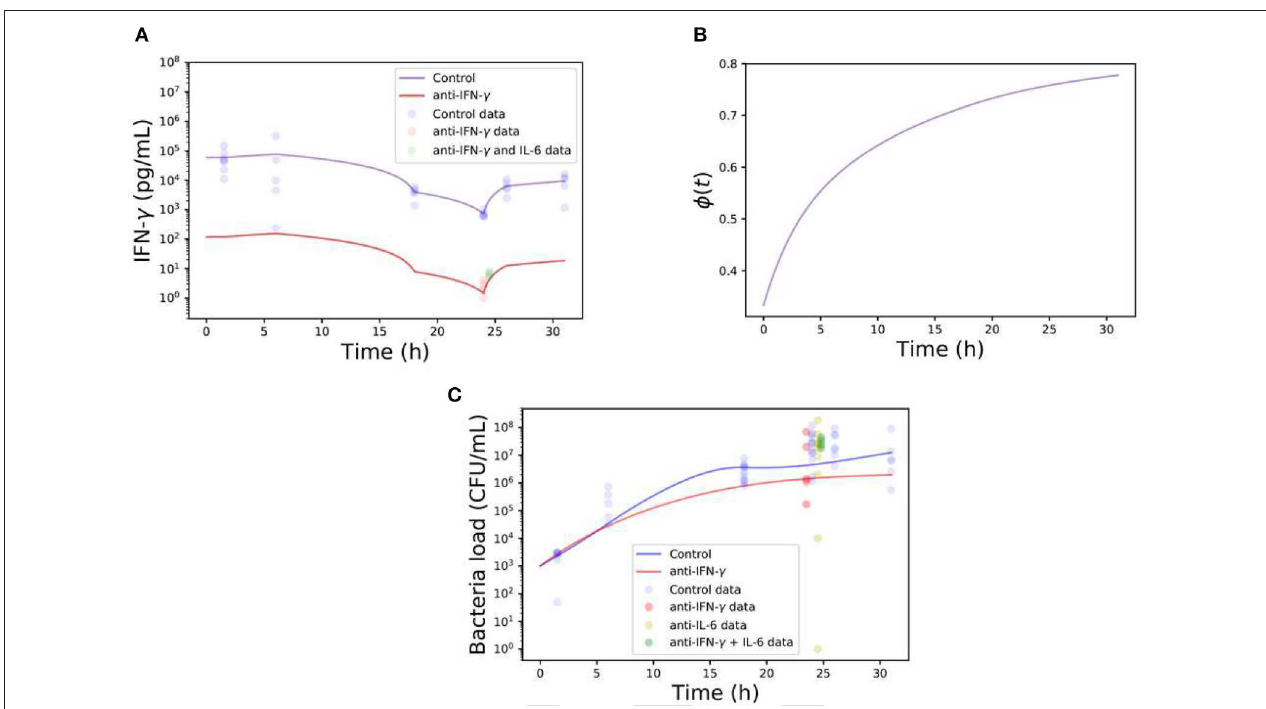
FIGURE 8 | Computational simulations of single or double-neutralization of IFN- γ and IL-6 during co-infection with 0.32 TCID 50 IAV and 1 × 10 6 CFU S. pn. (A) The blue line represents the IFN- γ kinetics during co-infection (control) and the red line shows the IFN- γ concentration kinetics based on the neutralization protocol ( ∼ 500-fold reduction respect co-infection). Note that the continuous blue line is built with a piecewise linear function of the experimental data points. The red line is based on the control case but adjusted to pass by the time point of anti-IFN- γ experiments. (B) Bacterial clearance function φ (Equation 5) during neutralization protocol of IFN- γ . (C) The blue line represents the bacterial load in the lungs during co-infection (control) while the red line displays the neutralization protocol. The different color dots represent the data of different neutralization protocols.